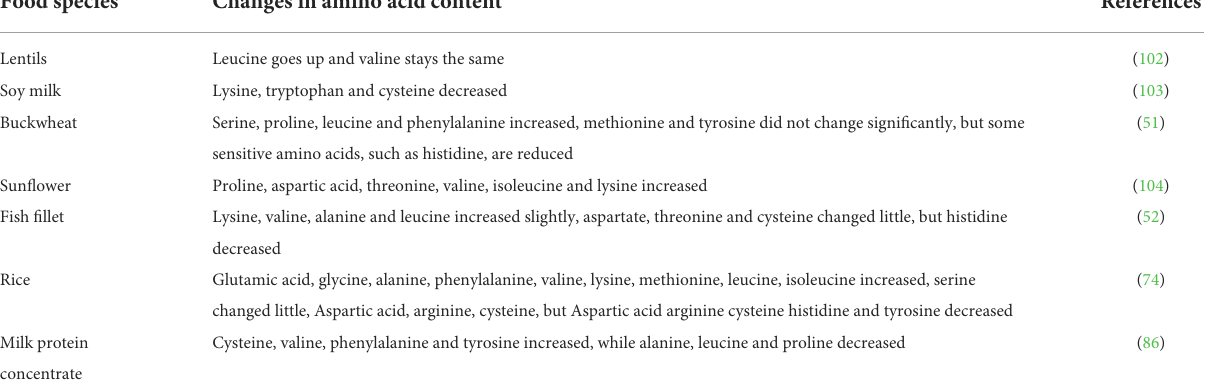
TABLE 7 Changes of different amino acid contents in food after microwave